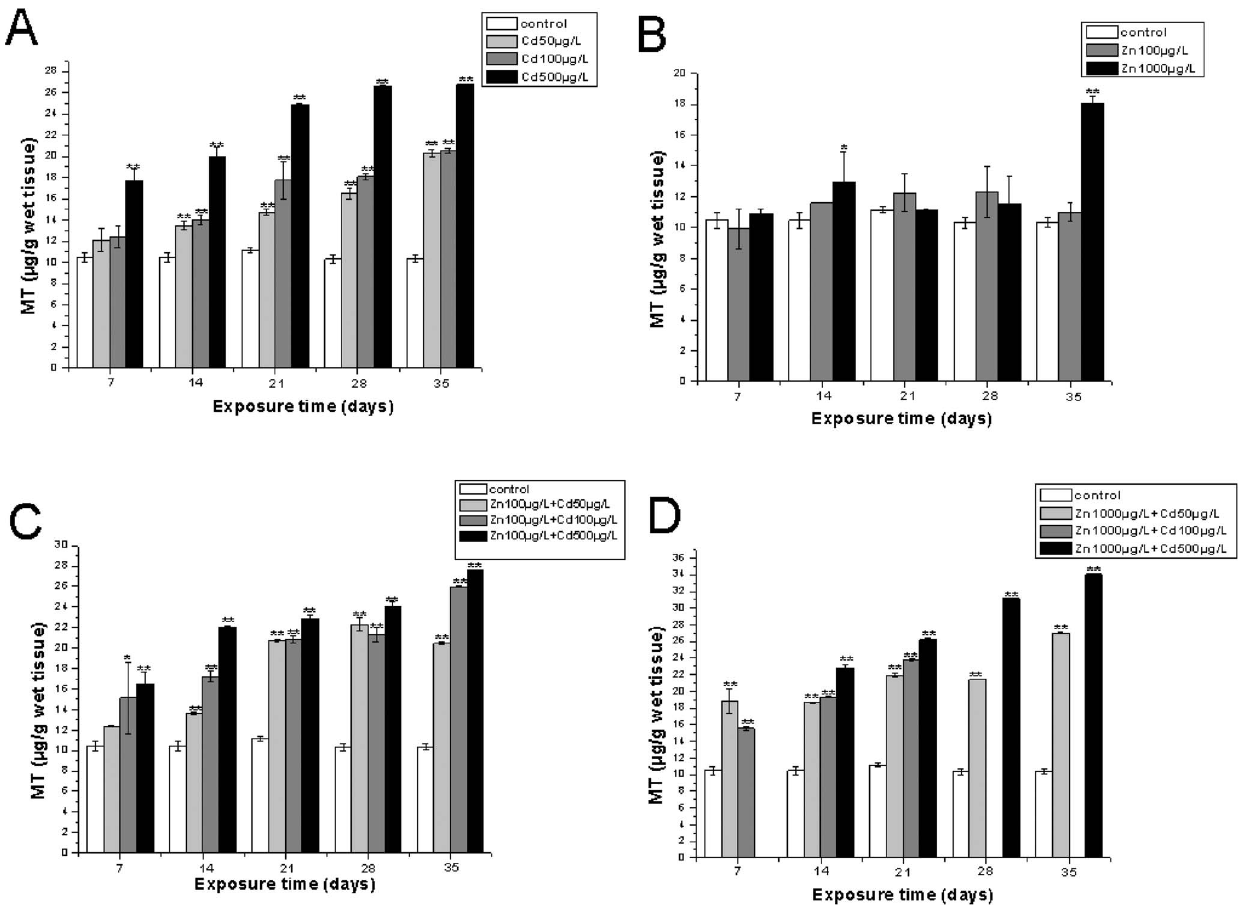
Figure 4. The MT levels in the hepatopancreas of S.henanense exposed to Cd and Zn as either single or both metals combined for 7, 14, 21, 28, 35days. Data were expressed as mean values 6 standard error. Statistical significances were analyzed using one-way ANOVA compared to the control, *P , 0.05, **P , 0.01.